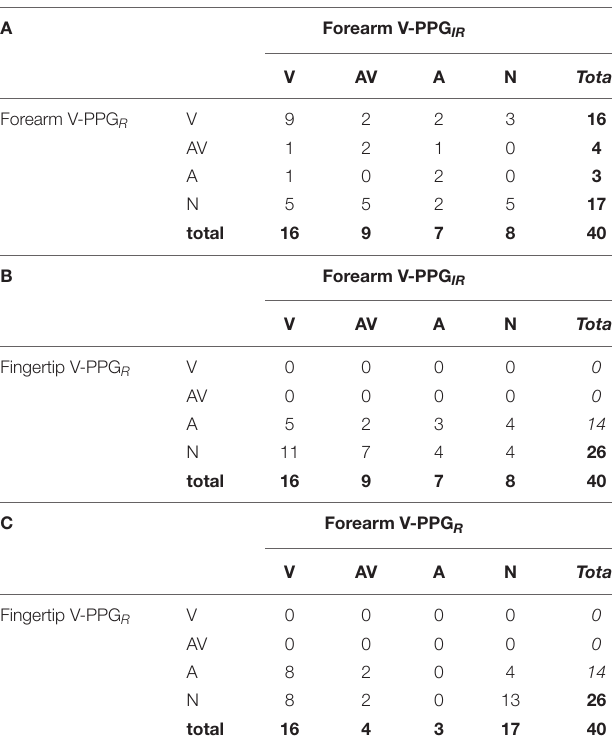
Tables A–C are forearm V-PPG IR vs. forearm V-PPG R , forearm V-PPG IR vs. fingertip V-PPG R , forearm V-PPG R vs. fingertip V-PPG R . V, AV, A, and N groups that are assumed indicative of isolated outflow impairment, arterial inflow/venous outflow simultaneous impairment, isolated inflow impairment, and normal responses, respectively (see text for